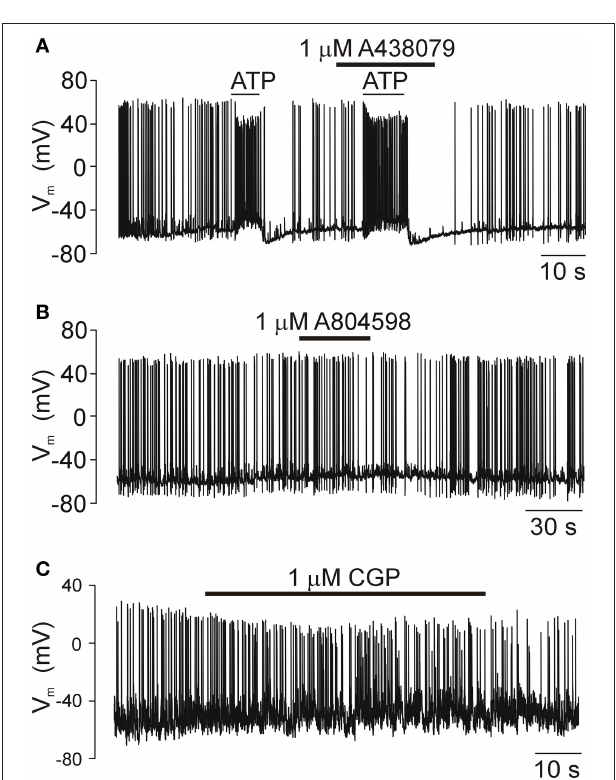
FIGURE 7 | The electrical activity of SCN neurons in acutely isolated slices is not modulated by P2X7R and mitochondria blockers. (A) The exogenous ATP application induced an increase in the frequency of action potentials as a result of the increased frequency of depolarizing GABAergic currents caused by the high concentration of chlorides in our intracellular solution (see the section Materials and Methods). The P2X7R-selective inhibitor A438079 had no effect on ATP-induced firing. (B) Prolonged application of A804598, another P2X7R blocker, also failed to change the electrical activity of SCN neurons. (C) A selective inhibitor of Na + -Ca 2 + exchanger in the mitochondria CGP37157 (CGP), gradually reduced the amplitude of action potentials with no effect on frequency. Traces shown in this figure are representative of 5–6 similar